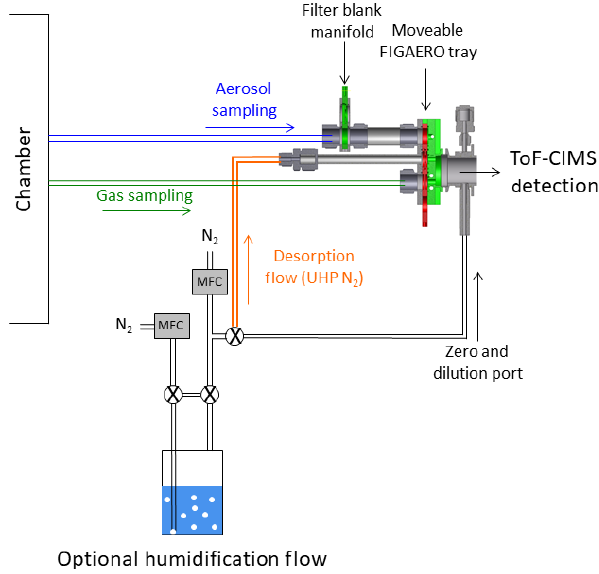
Figure 1. Schematic of the FIGAERO isothermal evaporation